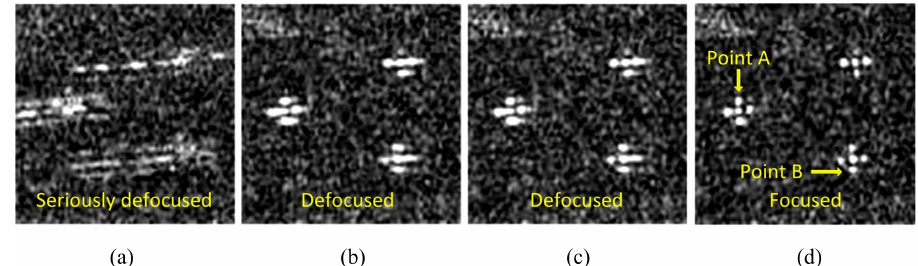
Figure 16. Magnified sub-scene images 2. ( a ) Processed with INS-only MOCO. ( b ) Processed with conventional MDA. ( c ) Processed with RDMDA. ( d ) Processed with 2D-SVMDA.